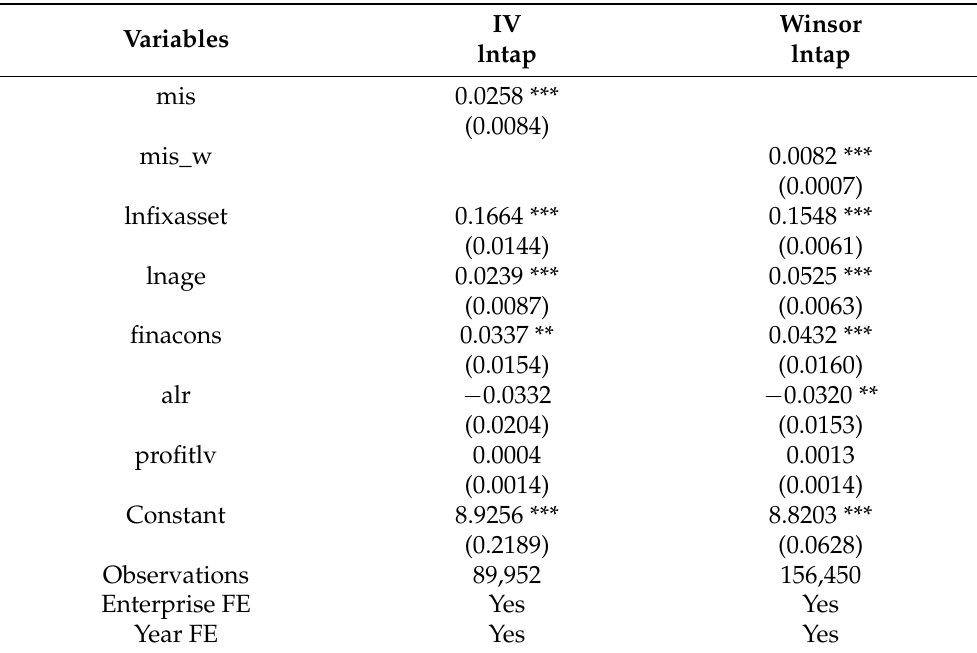
Table 7. Endogenous